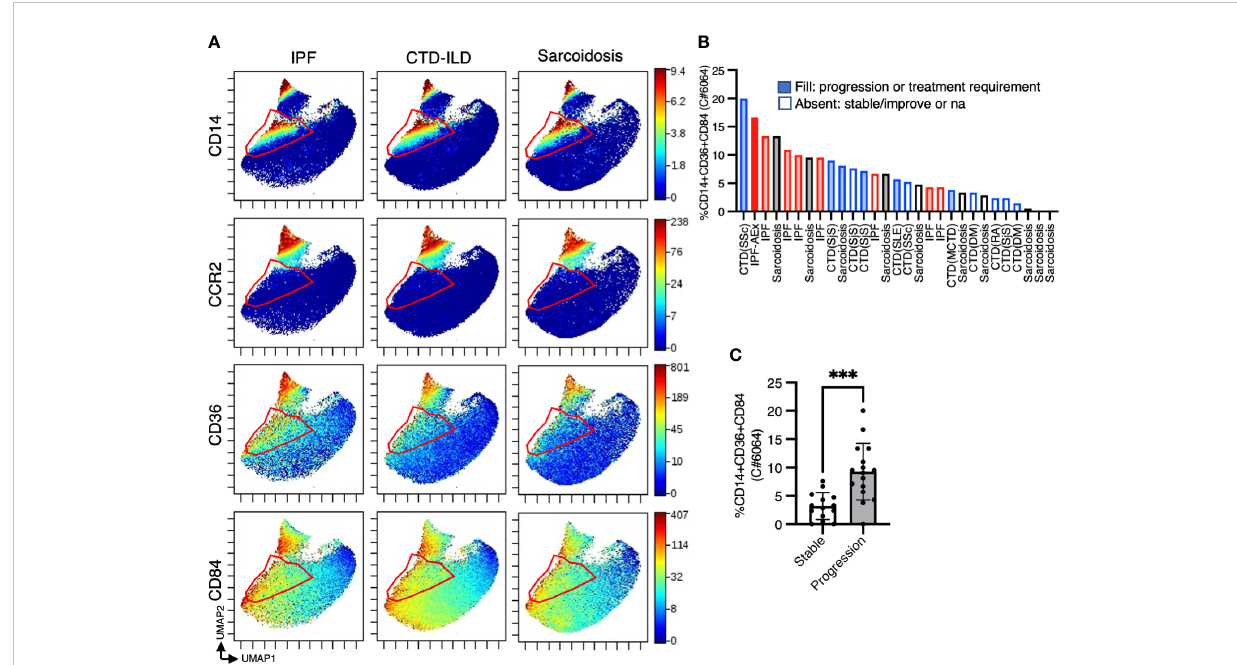
FIGURE 3 The proportion of CD14 + CD36 hi CD84 hi monocytes was correlated with disease progression. (A) UMAP plots showing CD14, CCR2, CD36, and CD84 expression in myeloid cells. Red triangles indicate CD14+ CCR2 – cell subpopulations. (B) The proportion of CD14 + CD36 hi CD84 hi monocytes (cluster #6064 de fi ned by the Citrus analysis in Figure 2C) abundance in myeloid cell populations in individual samples and (C) the correlation with disease progression. *** p < 0.001. Information for disease with clinical progression is also shown. IPF, idiopathic pulmonary fi brosis; CTD-ILD, connective-tissue disease-related interstitial lung disease; AEx, acute exacerbation; SSc, systemic sclerosis; SjS, Sjogren syndrome; SLE, systemic lupus erythematosus; RA, rheumatoid arthritis; DM, dermatomyositis; MCTD, mixed connective tissue disease; na, not